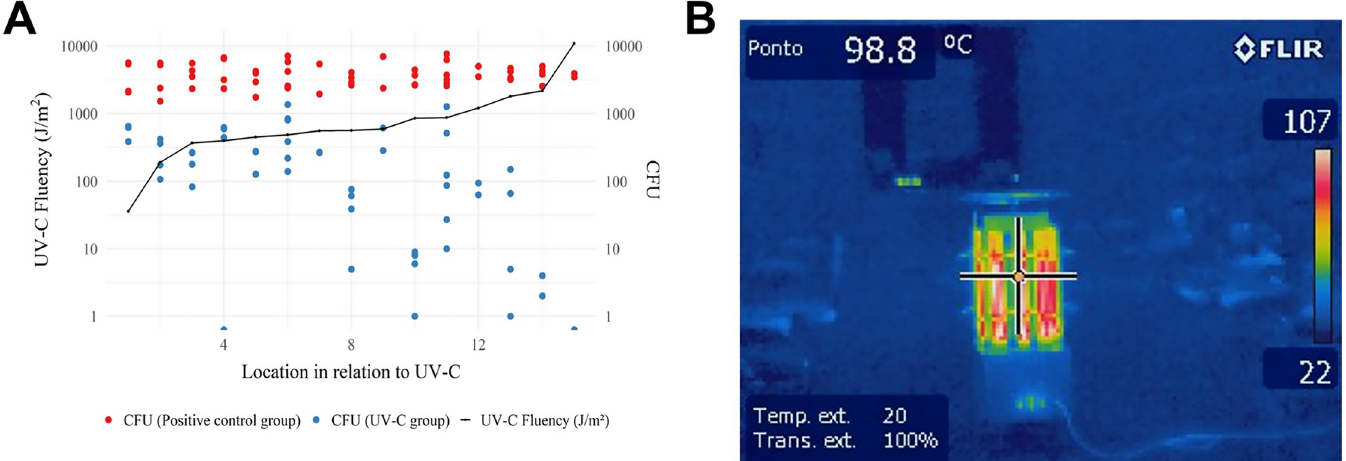
Fig 4. Correlation between CFU and UV-C fluency (J/m 2 ) (A) and thermal imaging of UV-C device